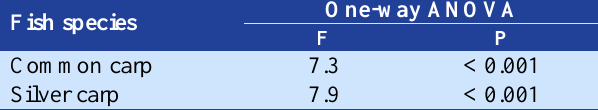
Table 4. Statistical analysis of mercury levels in the edible muscle, gill, liver, and skin of both species Fish